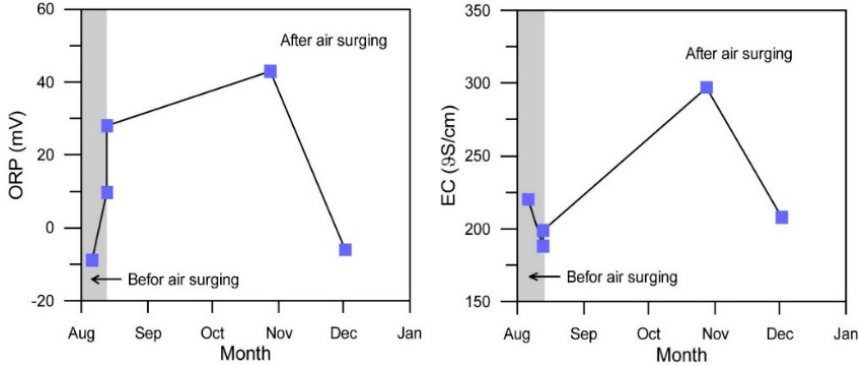
Figure 7. Temporal variation of water temperature, pH, dissolved oxygen, and electrical conductivity before and after air surging.